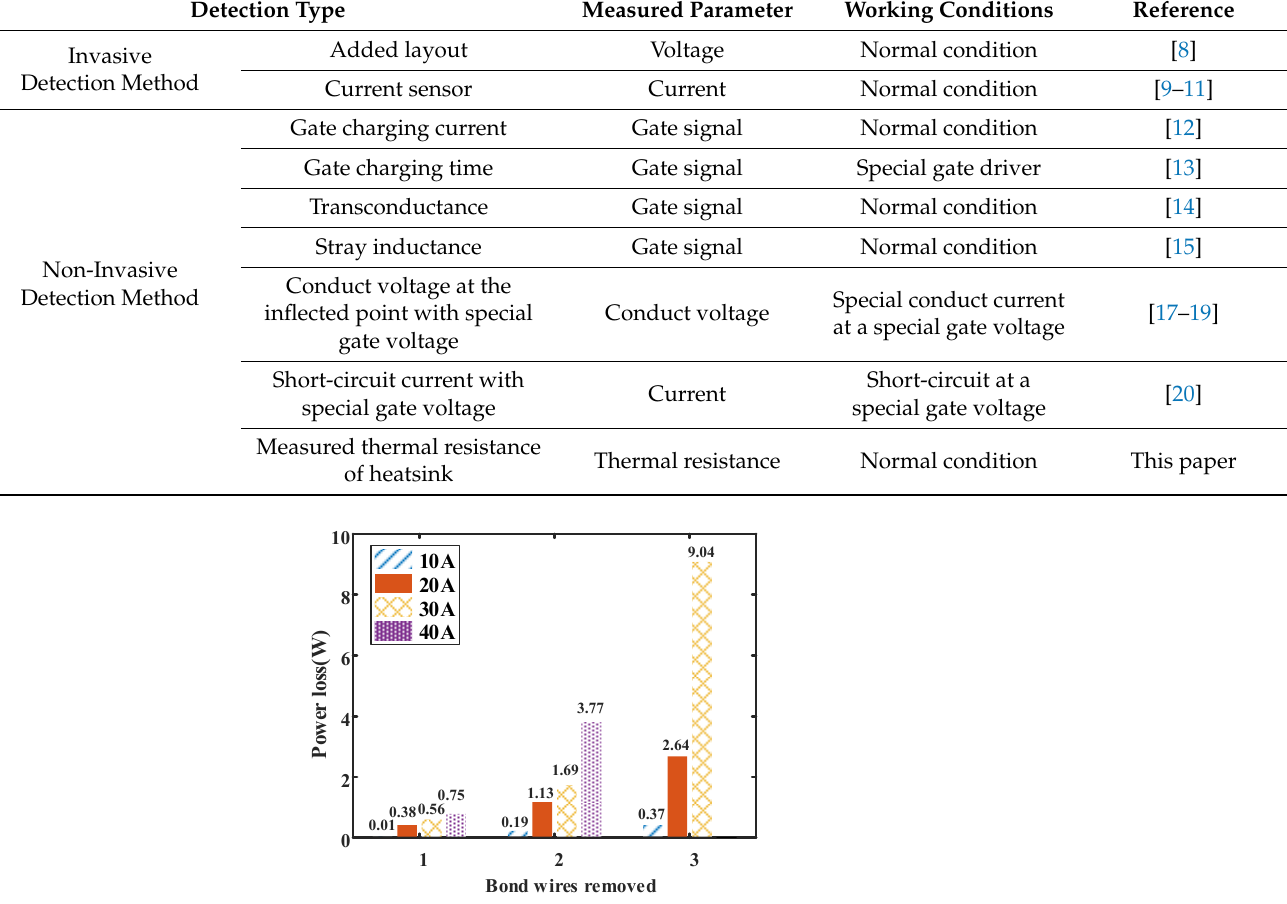
Figure 14. The growth of the IGBT module’s power loss after bond wires are removed.